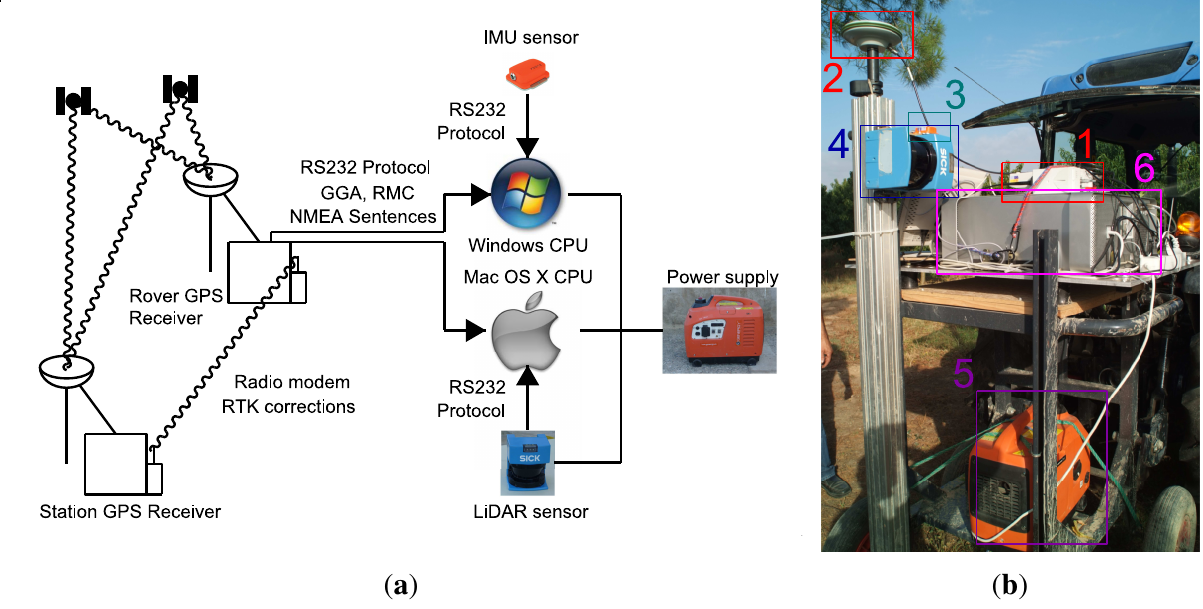
Figure 1. Terrestrial LiDAR system in combination with the IMU and RTK-GPS receiver.